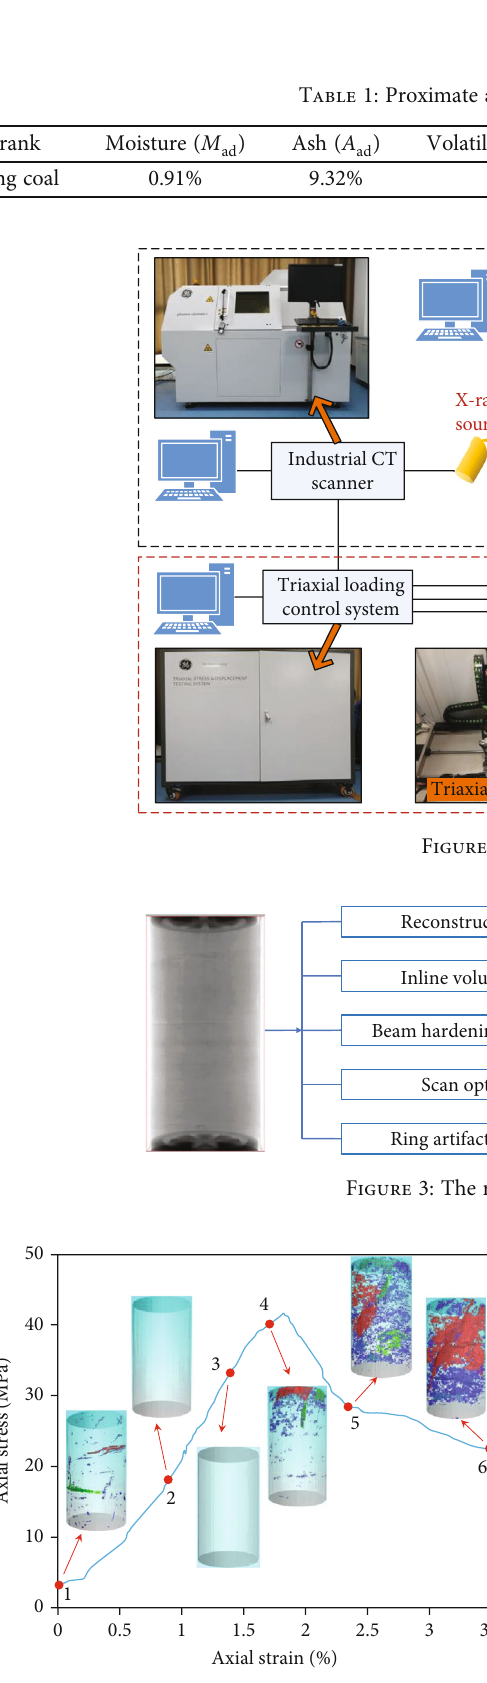
Figure 4: The stress-strain curve and three-dimensional fracture structure of the coal